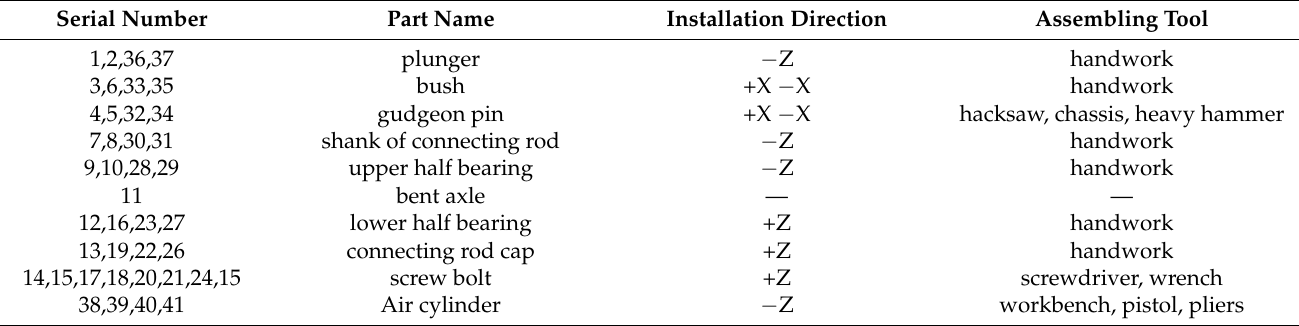
Table 4. Assembly properties of the crank linkage.